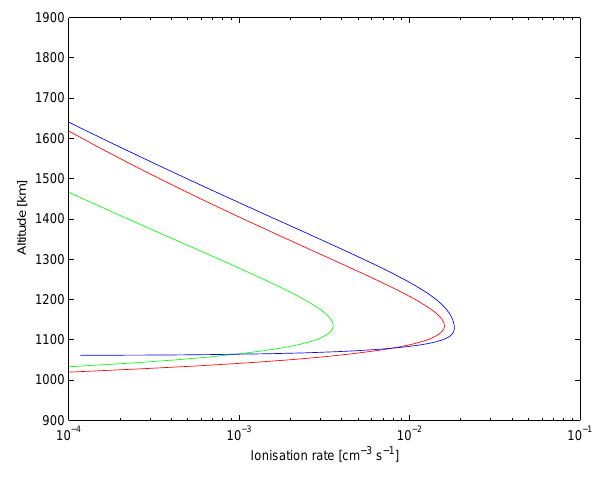
Fig.6. Densityprofiles of the major and minor species on Titanusedincalculations. Fig. 6. Density profiles of the major and minor species on Titan used in calculations.